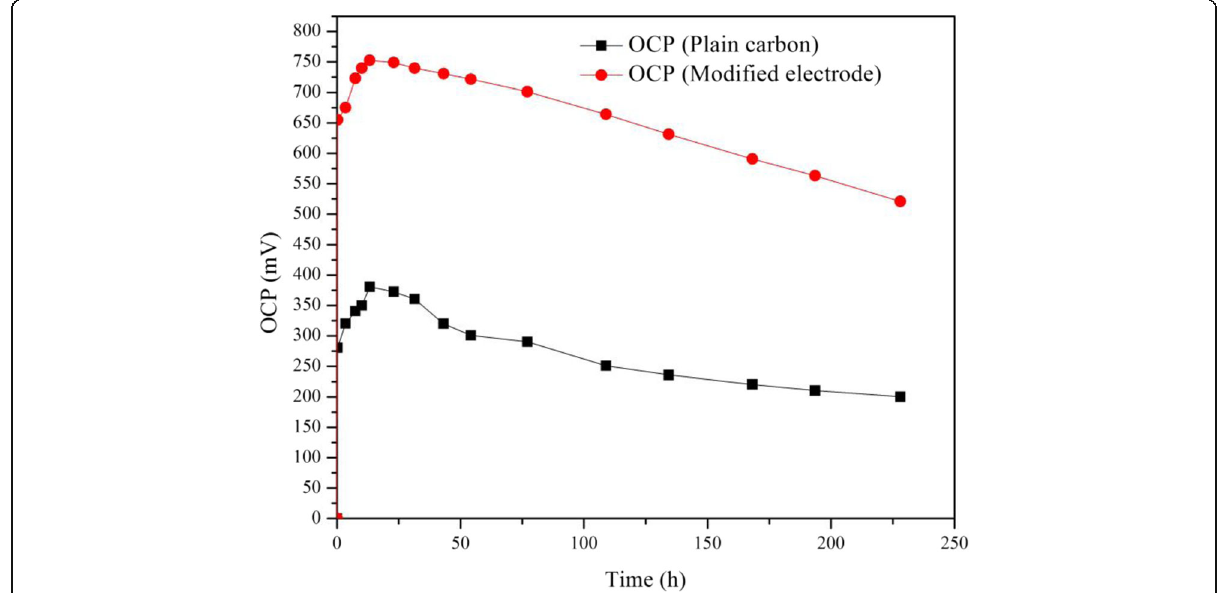
Fig. 1 Characteristics between open circuit potential (OCP) and time for plain carbon electrode and modified